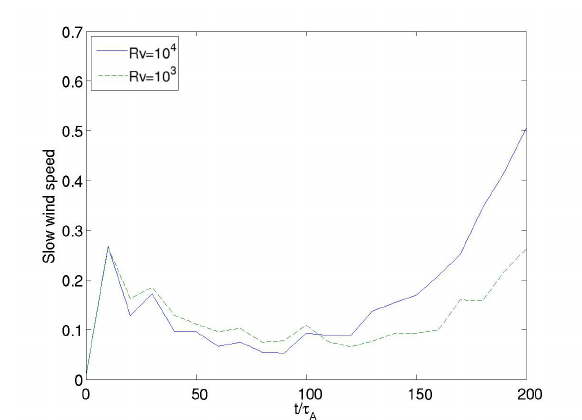
Fig. 12. Comparison of the time evolution of the vertical veloc- ity in the central axis in two runs starting from the initial 2-D hel- met streamer equilibrium with different viscosities ( R v = 10 3 and R v = 10 4 ) but equal resistivity S = 10 4